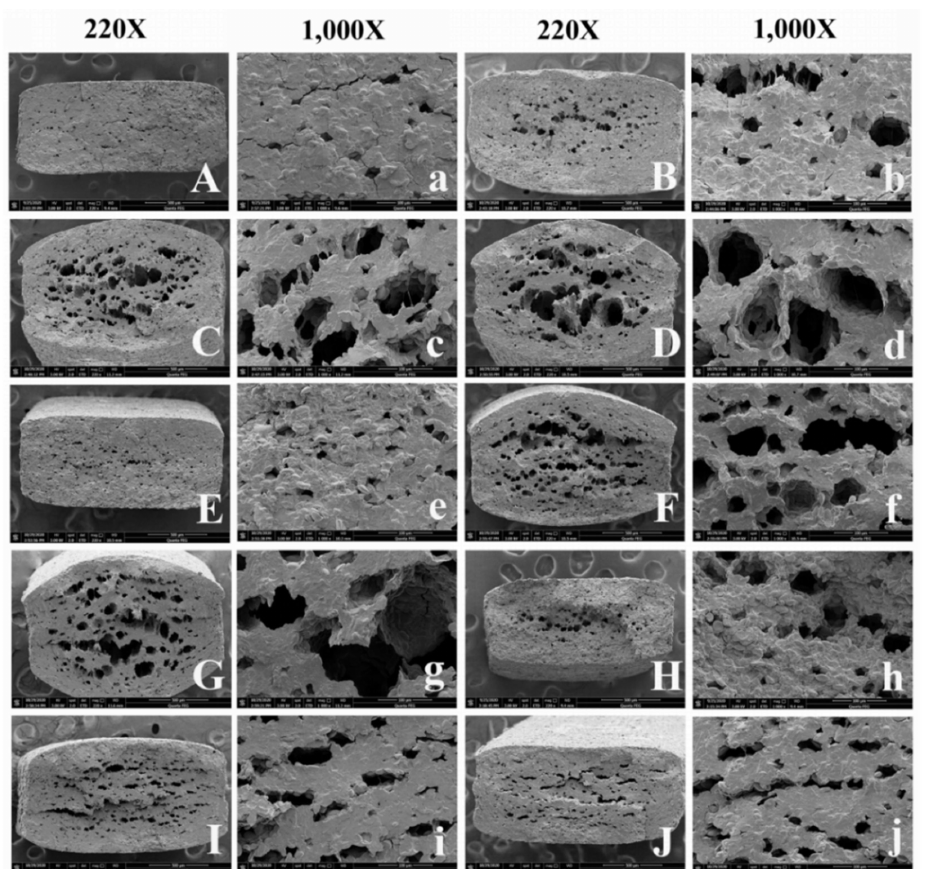
Figure 2. The scanning electron microscope photographs of dried noodles under different fermen- tation times and yeast additions. Capitalized letters indicate the cross-section of dried noodles magnified by 220 times. Lowercase letters indicate 1000 times magnification. Labels ( A ) and ( a ) represent dried unfermented noodles. ( B – D ) and ( b – d ) represent a fermentation time of 1 h and yeast addition of 0.2 g, 0.5 g and 1.0 g/100 g of total flour, respectively. ( E – G ) and ( e – g ) represent a fermentation time of 3 h and yeast addition of 0.2 g, 0.5 g and 1.0 g/100 g of total flour, respectively. ( H – J ) and ( h – j ) represent a fermentation time of 6 h and yeast addition of 0.2 g, 0.5 g and 1.0 g/100